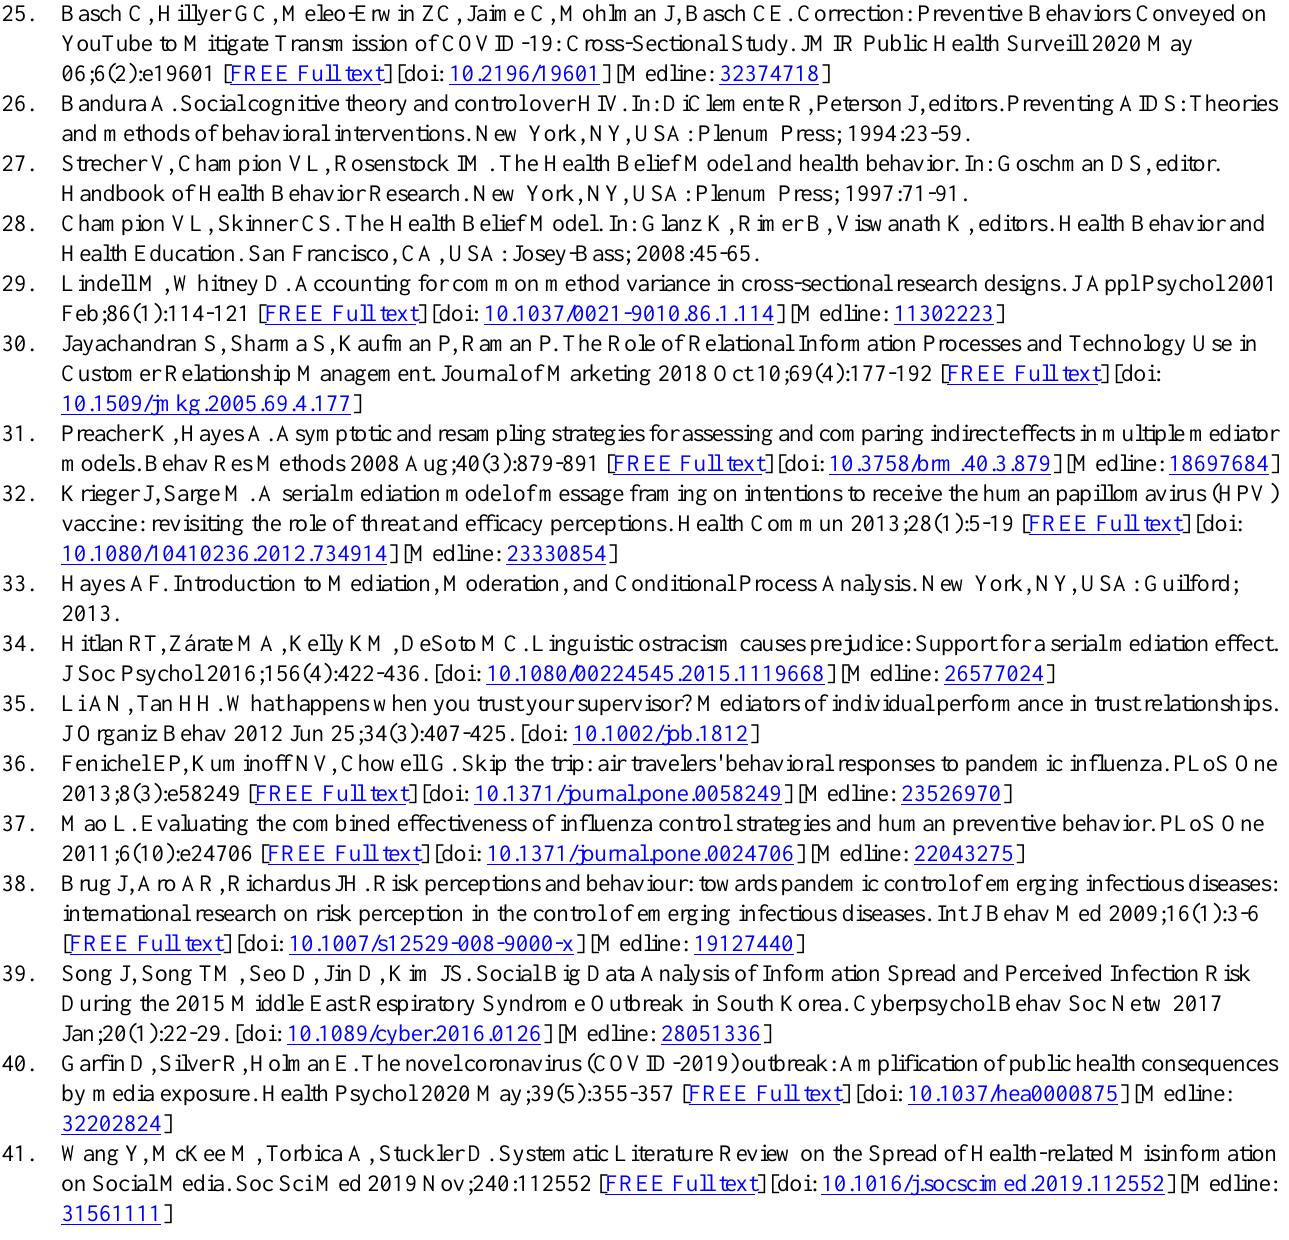
Abbreviations EVT: Expectancy-Value Theory HBM: Health Belief Model MERS: Middle East respiratory syndrome SARS: severe acute respiratory syndrome SCT: Social Cognitive